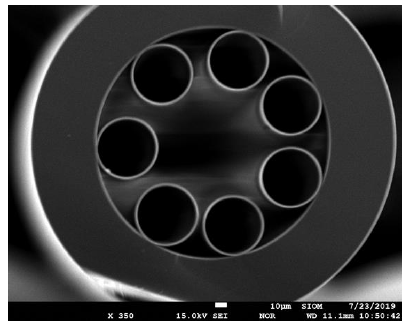
Figure 1. A SEM cross-section image of the fabricated Antiresonant Hollow-Core Fiber (ARHCF).